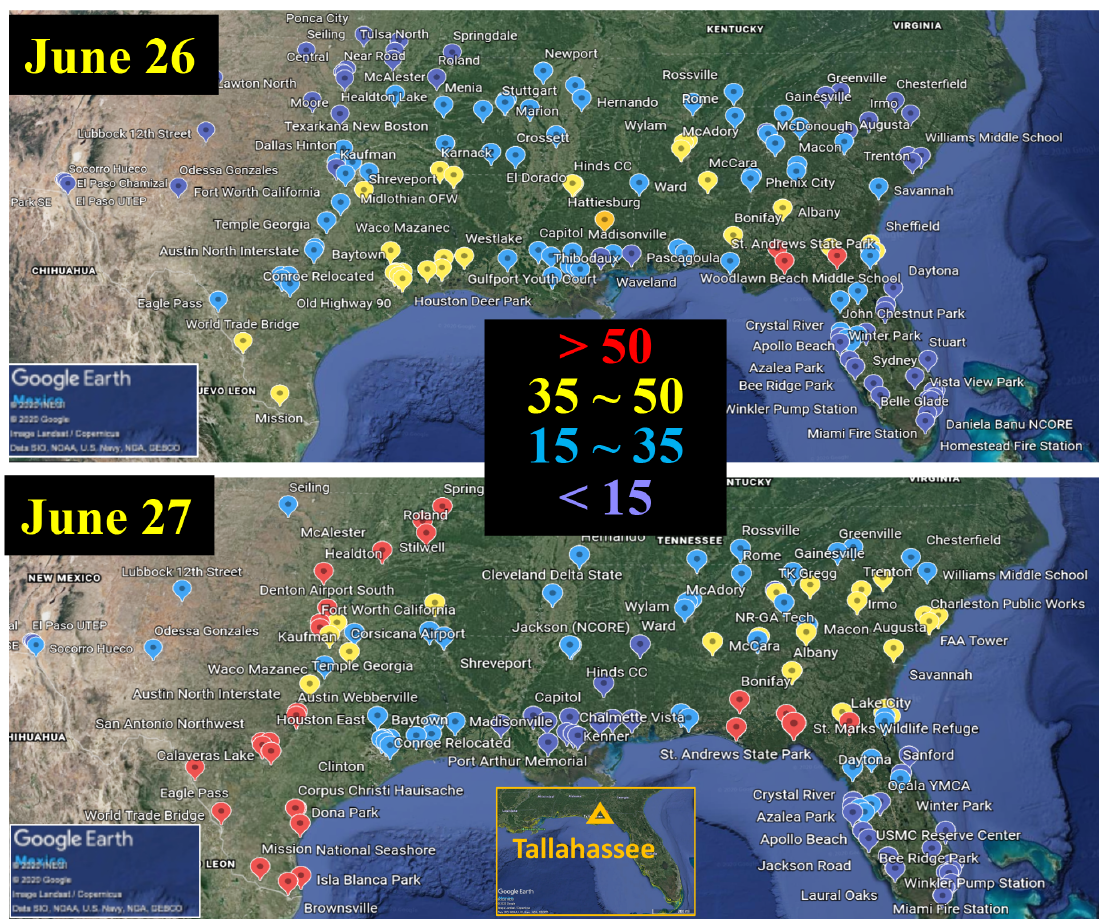
Figure 7. Observed PM 2 . 5 concentrations at the EPA air quality network over the southern US on 26 (top) and 27 June (bottom). PM 2 . 5 concentrations are categorized and marked with color in four ranges: < 15 (purple), 15–35 (blue), 35–50 (yellow), and > 50 (red)µgm − 3 . Note that the EPA air quality standard for 24h PM 2 . 5 is 35µgm − 3 . The location of Tallahassee is shown in the inset of the 27 June map. The background maps are copyrighted by © Google